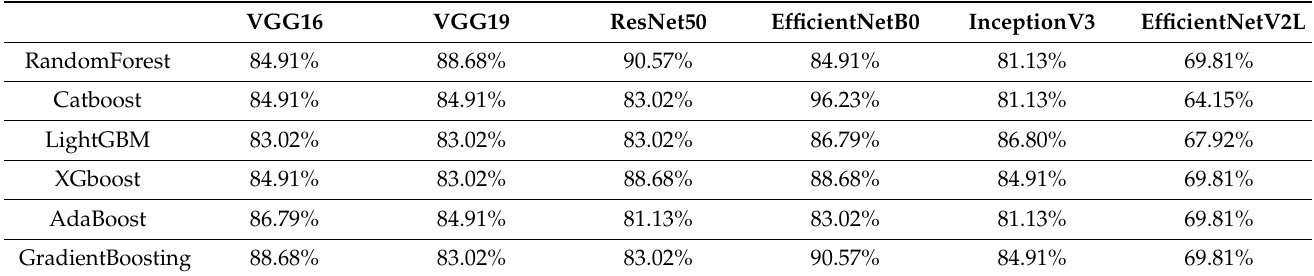
Table A20. Accuracy of each model combination for blue